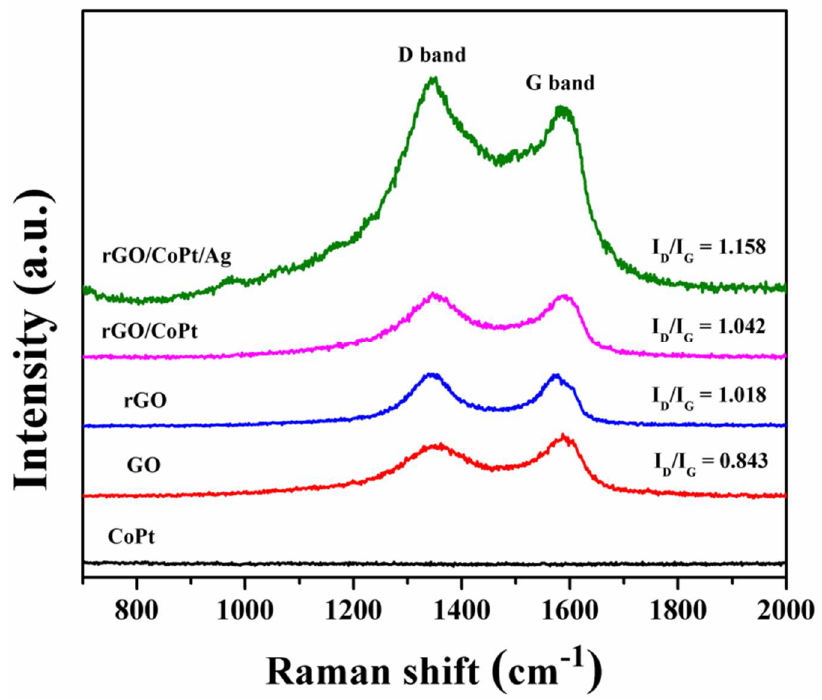
Figure 2. Raman spectra of CoPt, GO, rGO, rGO/CoPt, and rGO/CoPt/Ag. To verify the effective reduction of GO, and the formation of rGO/CoPt and rGO/CoPt /Ag nanocomposites, the FT-IR spectroscopy of all the samples was studied. Figure 3 displays absorption peaks of CoPt at about 879, 1049, 1087, 2923, and 2971 cm − 1 assigned to the C-H, C-O, C-N, and C-H groups, which may be a residue produced during the CoPt NPs’ formation process. The GO peaks are located at about 3422, 1732, 1625, 1397, and 1051 cm − 1 , corresponding to O-H, C=O, and skeletal vibrations of the graphitic domains, C-OH and C-O, respectively [41,42]. It is well-known that the peaks of oxygen-containing groups would become weak or disappear when the GO is reduced into rGO [33,43]. However, compared to GO, the relative peak intensities of those oxygen-containing groups (3422, 1397, and 1051 cm − 1 ) increase in rGO/CoPt and rGO/CoPt/Ag, which may be due to the presence of CoPt NPs, and this result may confirm the formation of the